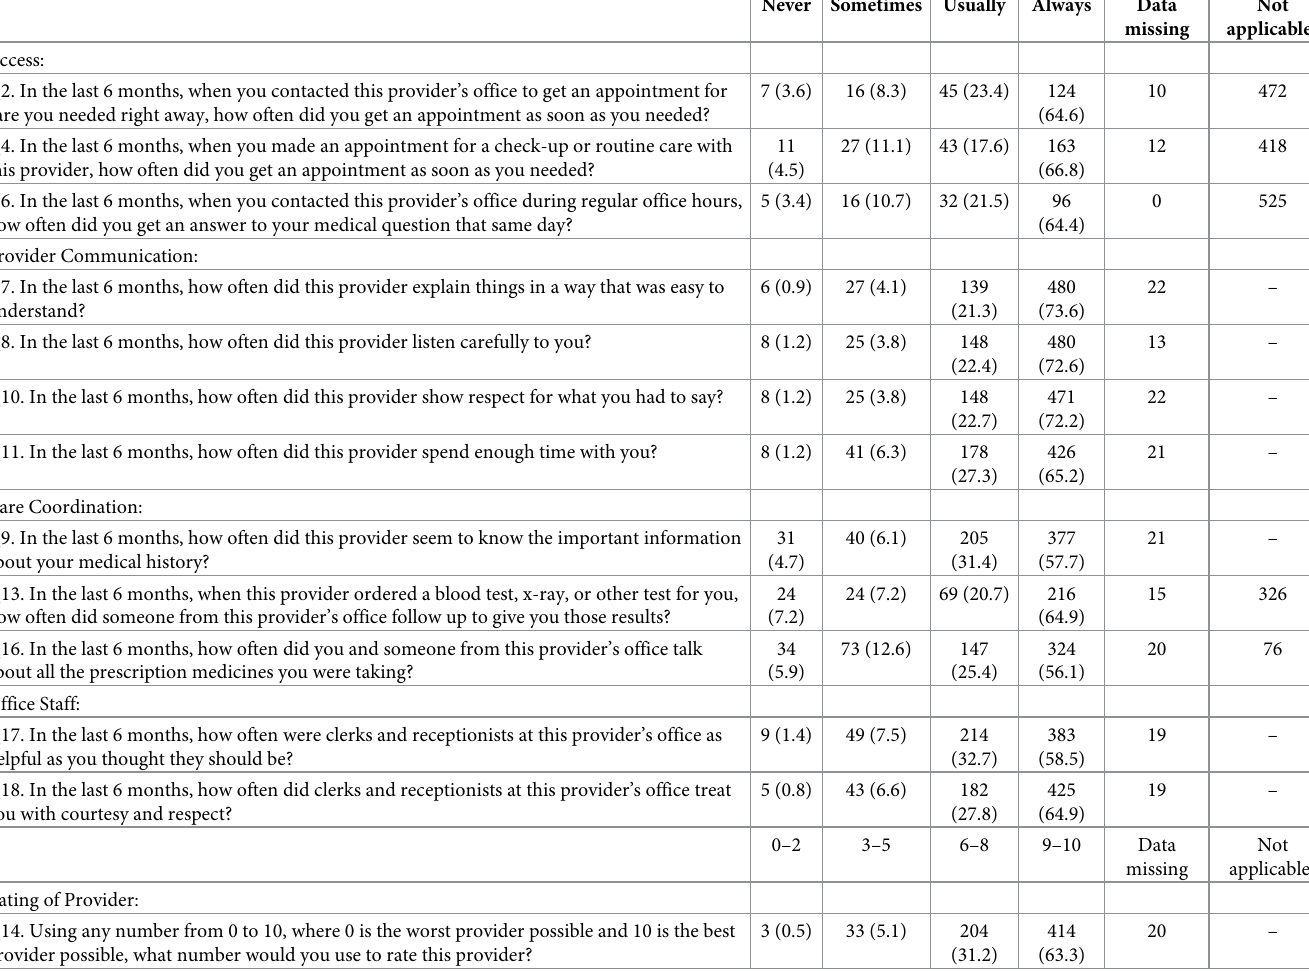
Table 2. Response to Japanese CG-CAHPS items (N = 674): Number (%).